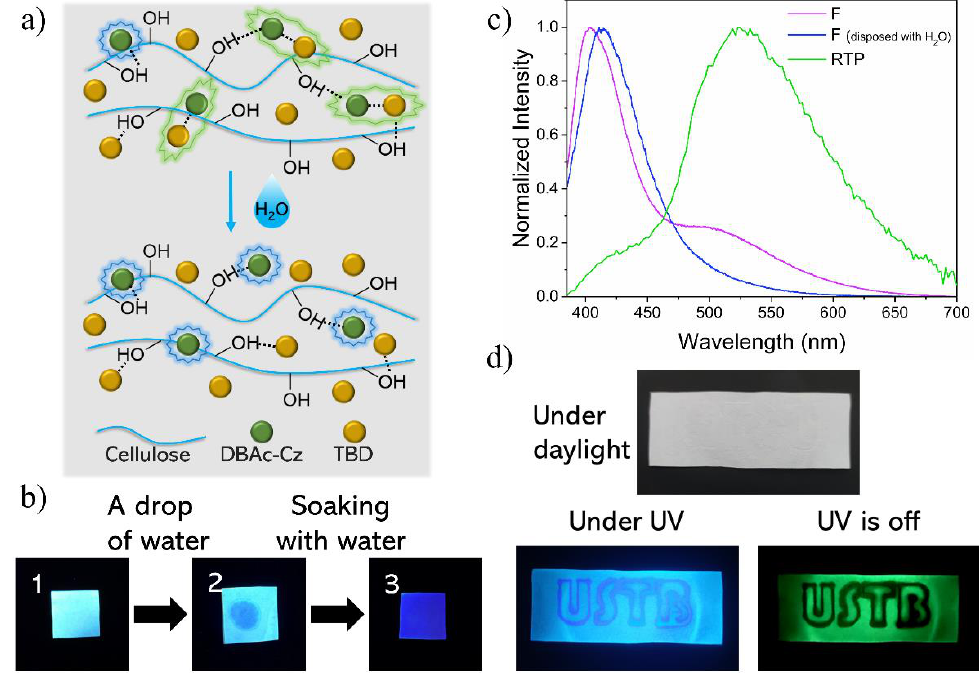
Figure 5. ( a ) Schematic illustration of DT embedded in paper (cellulose) and after water-processed. ( b ) Graphs of samples under 365 nm UV lamp. DT ink infiltrated paper (1), DT ink infiltrated paper with a drop of water on it and then dried (2), DT ink infiltrated paper soaked with water and then dried (3). ( c ) Steady-PL spectra of DT ink infiltrated paper, DT ink & water infiltrated paper and phosphorescence spectra of DT ink disposed filter paper (F: fluorescence, RTP: room temperature phosphorescence). ( d ) DT ink infiltrated paper was written with water to achieve word encryption. Graphs of the sample under daylight, under and after the removal of 365 nm UV light.